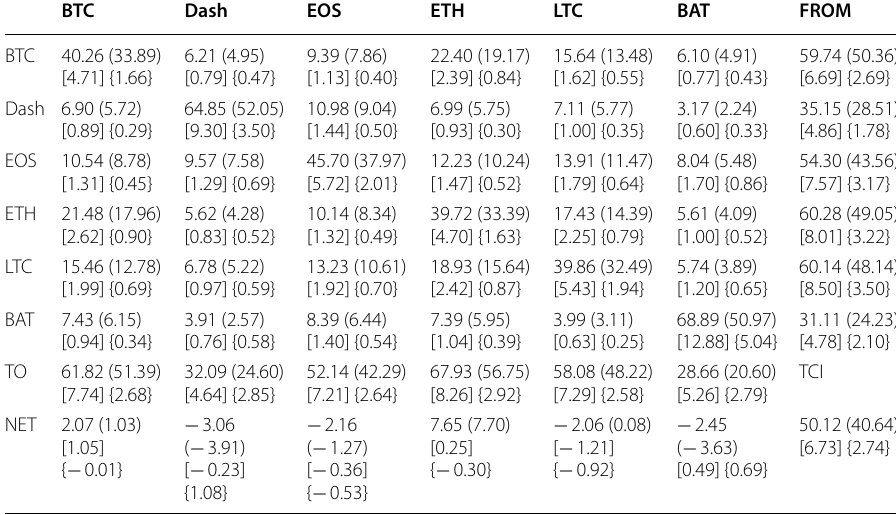
The values in parentheses (), square brackets [], and curly brace {} denote the short‑term (1–5 days), medium‑term (5–22 days), and long‑term (more than 22 days) frequency connectedness